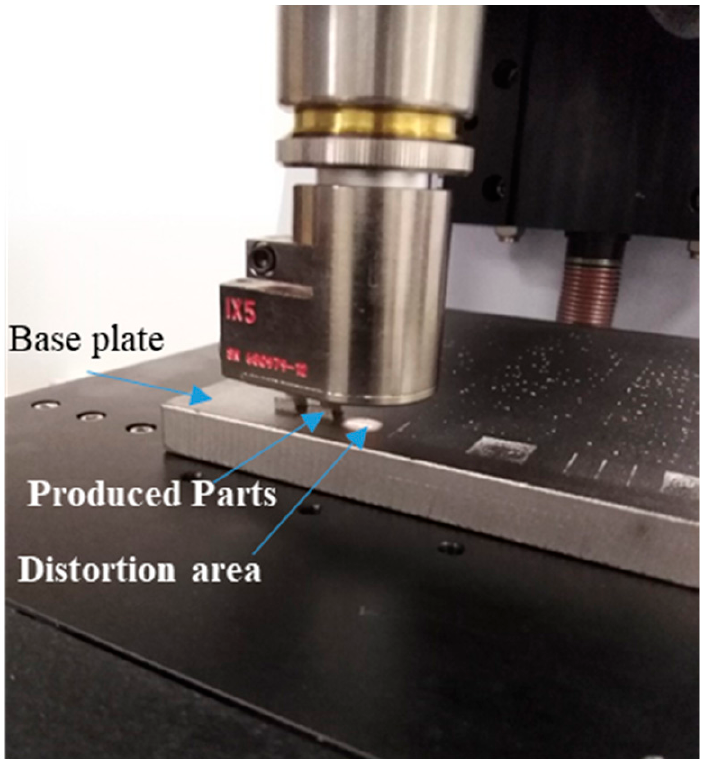
Figure 9. The Contour GTK 3D profilometer from Bruker.